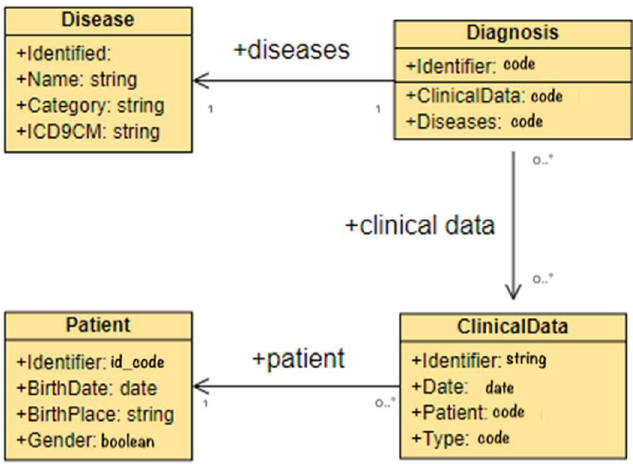
Figure 3. E-R schema of extracted data case study .